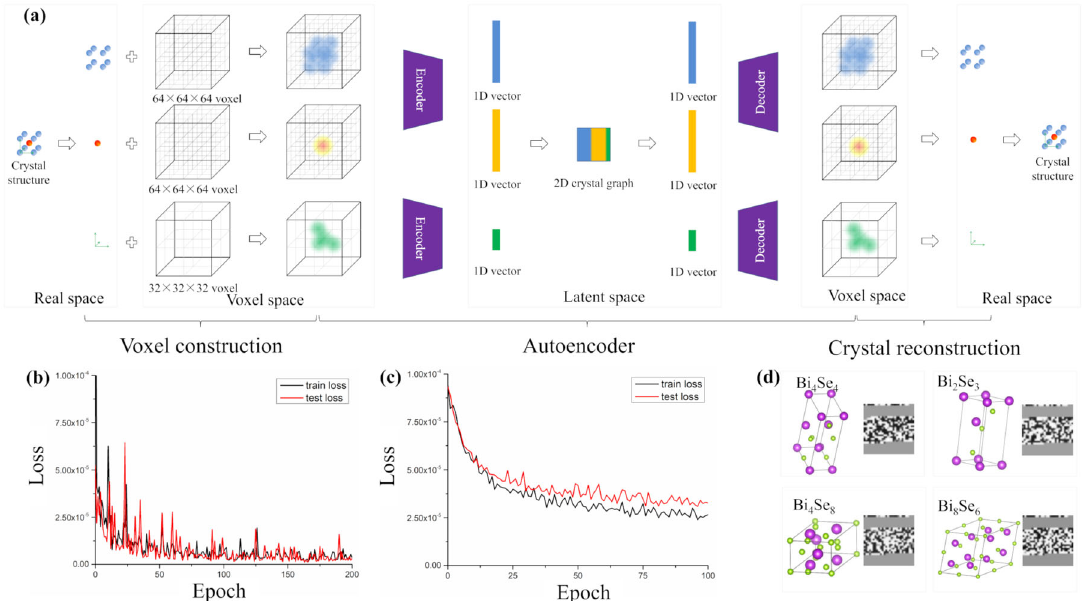
Fig. 1 Construction of 2D crystal graphs. (a) Schematic diagram of generating 2D crystal graphs; ( b ) Learning curve of lattice autoencoder, where the red line represents the test loss and the black line represents the training loss; ( c ) Learning curve of sites autoencoder, where the red line represents the test loss and the black line represents the training loss; ( d ) Four typical crystal structures (Bi 4 Se 4 , Bi 2 Se 3 , Bi 4 Se 8 , Bi 8 Se 6 ) and their corresponding 2D crystal